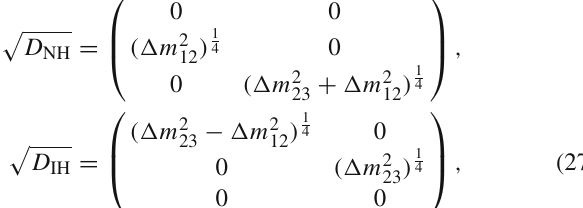
Fig. 7 In the left (right) panel, we show the parameter scan results for the maximum allowed branching ratios, μ ± μ ± W ∓ W ∓ ) , as a function of a Majorana phase ρ case. The solid curve denotes the maximum value of the branching ratio